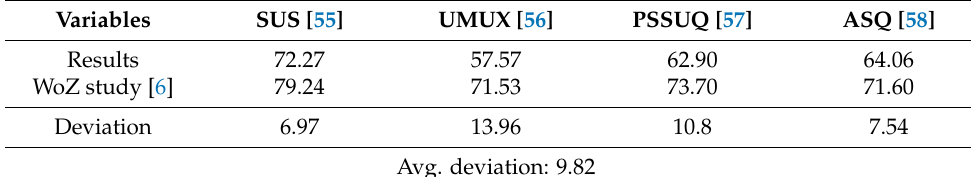
Table 5. Comparison